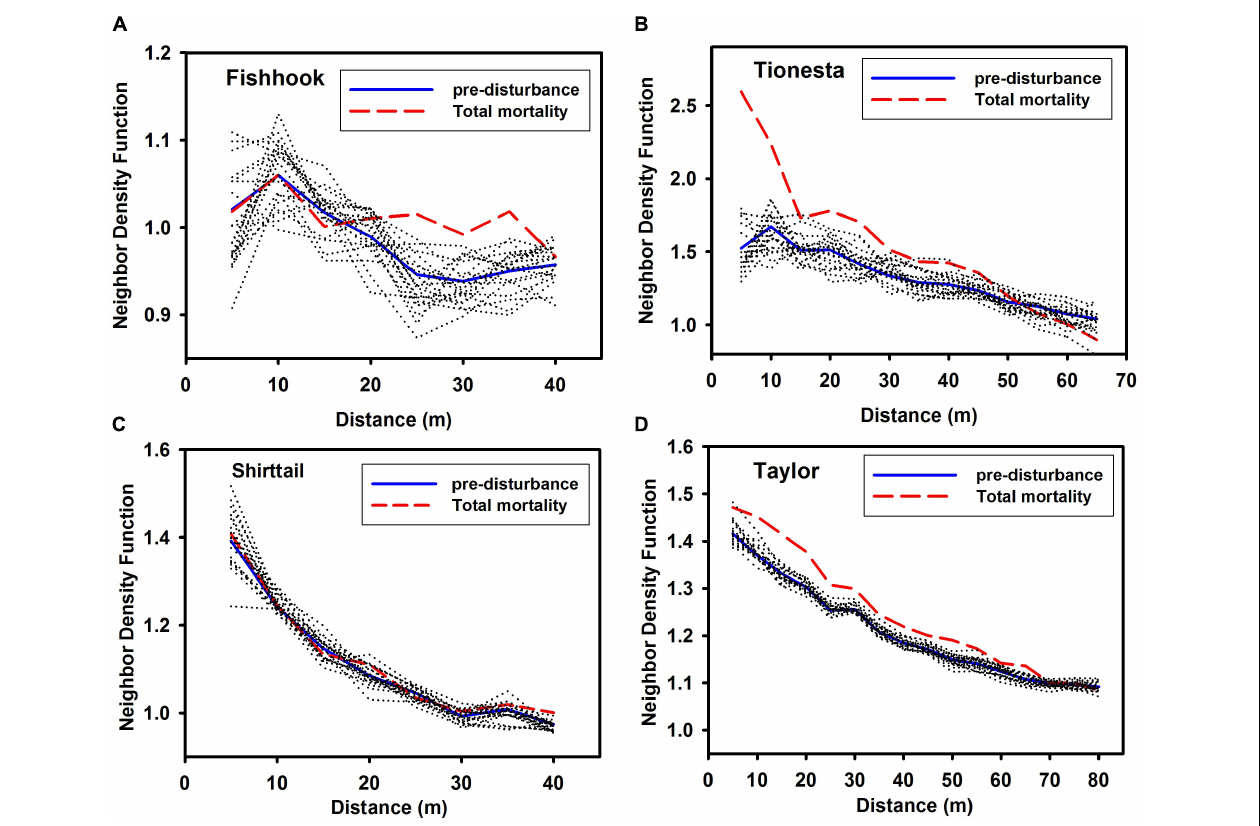
FIGURE 4 | Neighbor density function of all pre-disturbance trees in stands at the four sites, and all fallen trees (‘total mortality’). (A) Fishhook; (B) Tionesta; (C) Shirttail; and (D) Taylor. Note that x and y axes differ among the panels in this figure. Pre-disturbance NDF shown with solid lines; total mortality NDF shown with dashed lines. Dotted lines shown NDF for 20 separate random selections from among the pre-disturbance trees, with n = the number of fallen trees at that site. Values greater than unity are more aggregated than random; values less than unity are more uniform than random. Values at any given distance that are outside the extremes of the 20 randomizations indicate that the spatial pattern of mortality is significantly non-random, given the pre-disturbance distribution of trees.